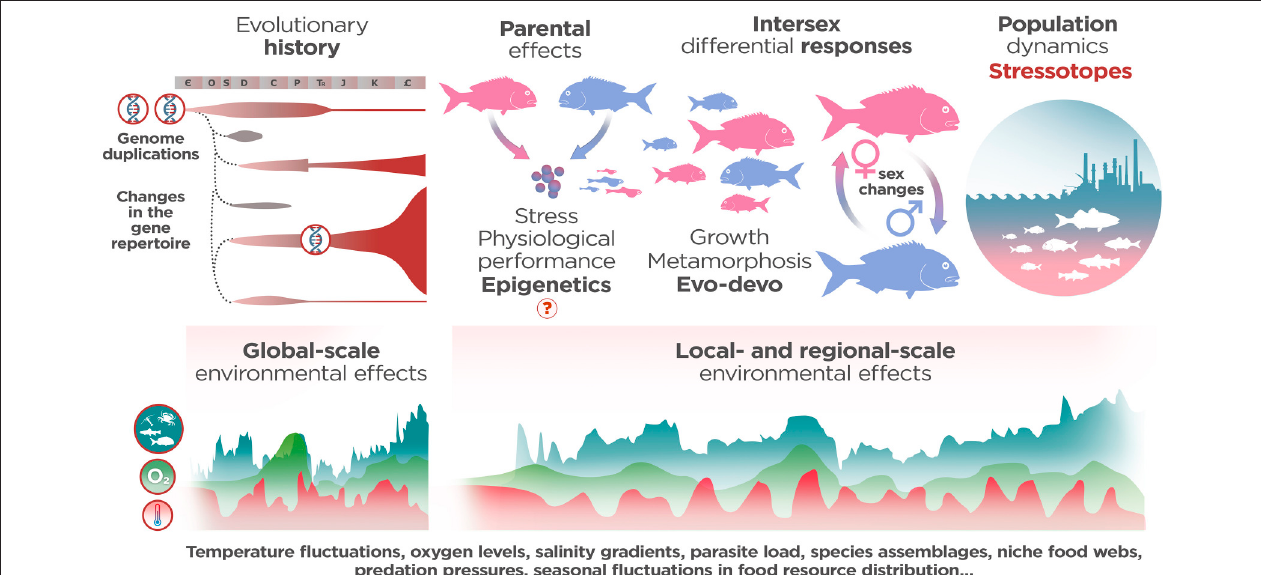
FIGURE 1 | Several influences that shape distress-related phenotypes in fish. The analysis of common responses to stress relies on (1) the evolutionary life-stories endured by each species (i.e., genome duplications, changes in stress-related gene pools, changes in oxygen and temperature levels over geologic time and dynamics of extinction/speciation throughout Earth’s history) that constraint the evolvability of biological systems and (2) the pattern and scale of environmental effects in a particular biotope. When analyzing a particular stress-related phenotype the physiological outcomes of specific gene networks during the twin processes of development and growth/metamorphosis have been taken into account, but also the effects of epigenetic transmission of cortisol sensitivity, the differential responses to stressors between sexes and the behavioral interactions within populations as starting points. In this sense, a stressotope defines the boundaries of common pan-specific maladaptive stress responses in a particular/local biotope not only from the perspective of abnormal changes in environmental resources, but also, from the global-scale changes recapitulated in the life story of each individual, i.e., the functional genomics and phenomics of stress intertwined with functional ecology across spatial